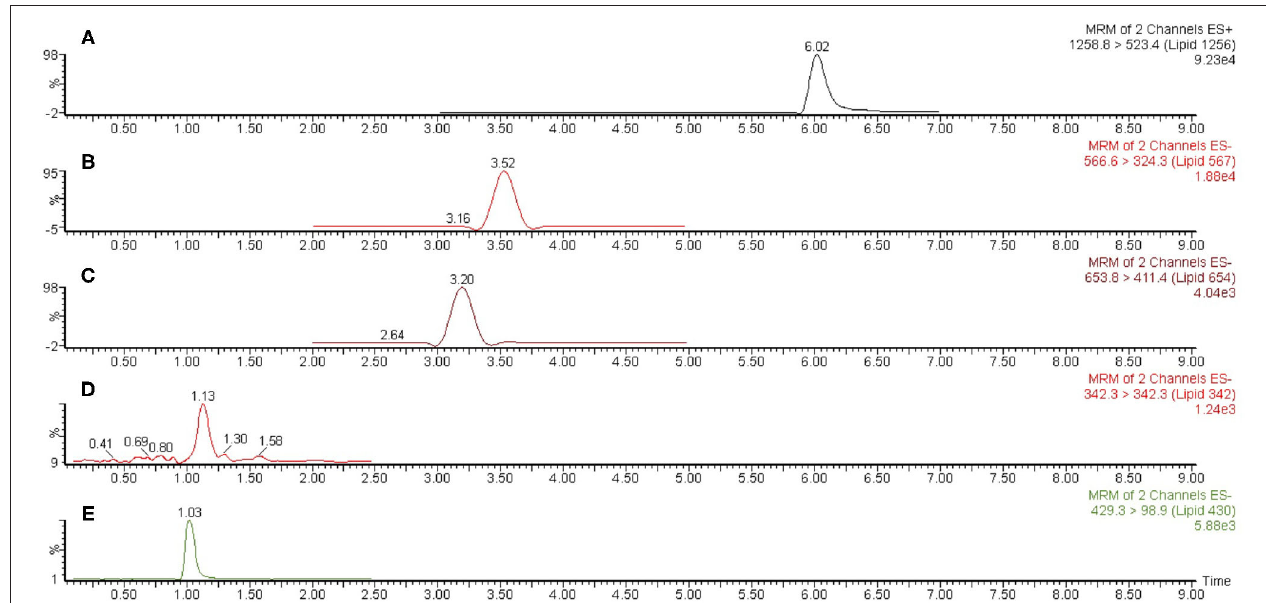
FIGURE 2 | Representative liquid chromatography-mass spectrometric (LC-MS) scan of P. gingivalis (ATCC 33277) total lipids. A sample of P. gingivalis total lipids was dissolved in methanol and analyzed by LC-MS as described in section Materials and Methods. Scan (A) represents Lipid 1256 monitored as the m/z 1258.8 to 523.4 positive ion multiple reaction monitoring (MRM) transition, scan (B) represents Lipid 567 monitored as the m/z 566.6 to 324.3 negative ion MRM transition, scan (C) represents Lipid 654 monitored as the m/z 653.8 to 411.4 negative ion MRM transition, scan (D) represents Lipid 342 monitored as the m/z 342.3 negative ion scan and scan E represents Lipid 430 monitored as the m/z 429.3 to 98.9 negative ion MRM transition. The MRM ion peaks were electronically integrated in order to calculate the relative abundance of each serine/glycine lipid